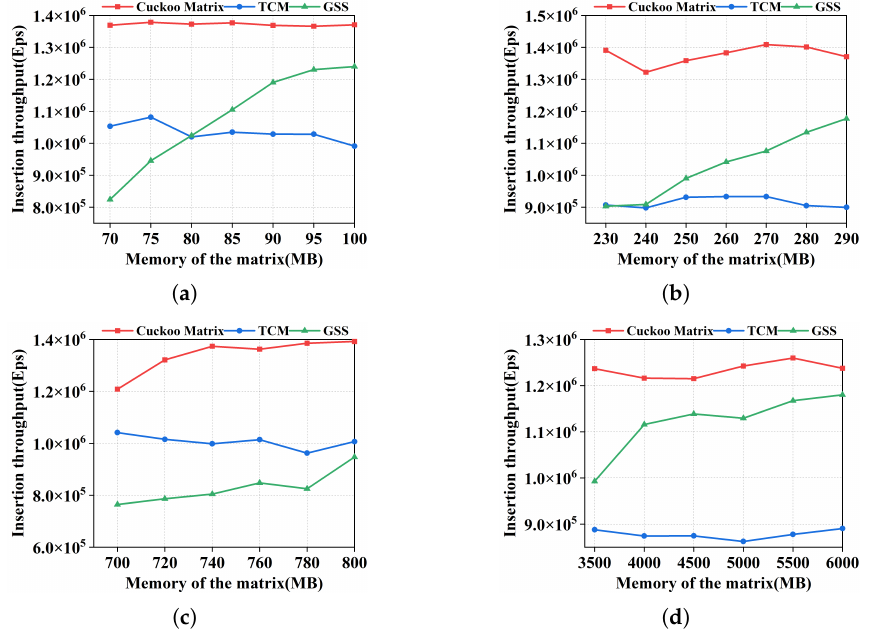
Figure 3. Throughput of insertion. ( a ) Skitter. ( b ) DBLP. ( c ) Orkut. ( d ) Wiki.